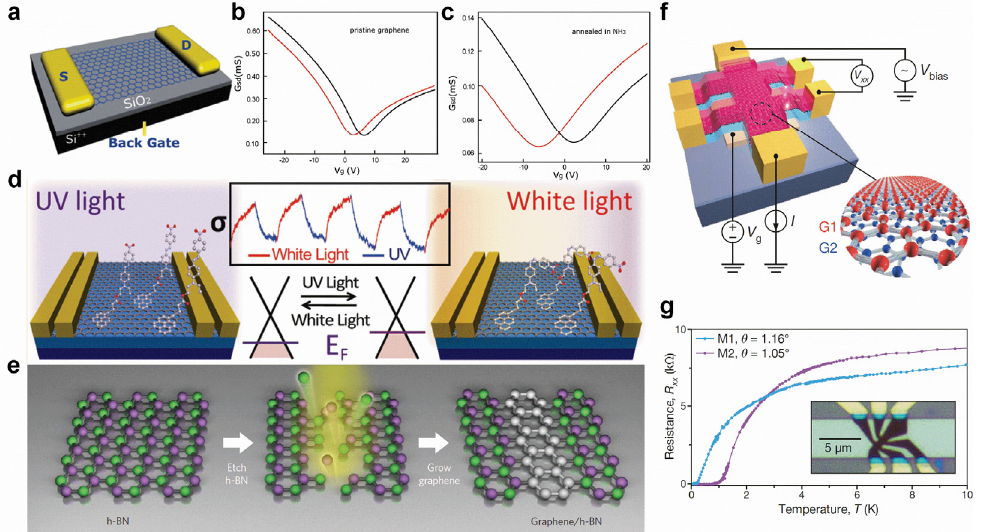
Figure 6. Surface modifications of graphene. ( a – c ) Comparison between the transfer characteristics of different graphene-based FETs (black and red curves were measured in air and in vacuum re- spectively). ( a ) Scheme of a graphene-based FET device. ( b , c ) The transport properties of ( b ) pristine graphene and ( c ) graphene annealed in NH 3 after irradiation measured at V sd = 0.03 V. ( d ) Light- driven conductance modulation of graphene with adsorption of DR1P molecules. ( e ) Fabrication of in-plane graphene/h-BN heterostructures. ( f ) Schematic of a twisted bilayer graphene device and four-probe measurement system. ( g ) Superconductivity in twisted bilayer graphene. ( a – c ) Reprinted with permission from Ref. [118]. Copyright, 2010 American Chemical Society. ( d ) Reprinted with permission from Ref. [36]. Copyright 2012, American Chemical Society. ( e ) Reprinted with permis- sion from Ref. [42]. Copyright 2013, Springer Nature Ltd. ( f , g ) Reprinted with permission from Ref. [52]. Copyright 2018, Springer Nature